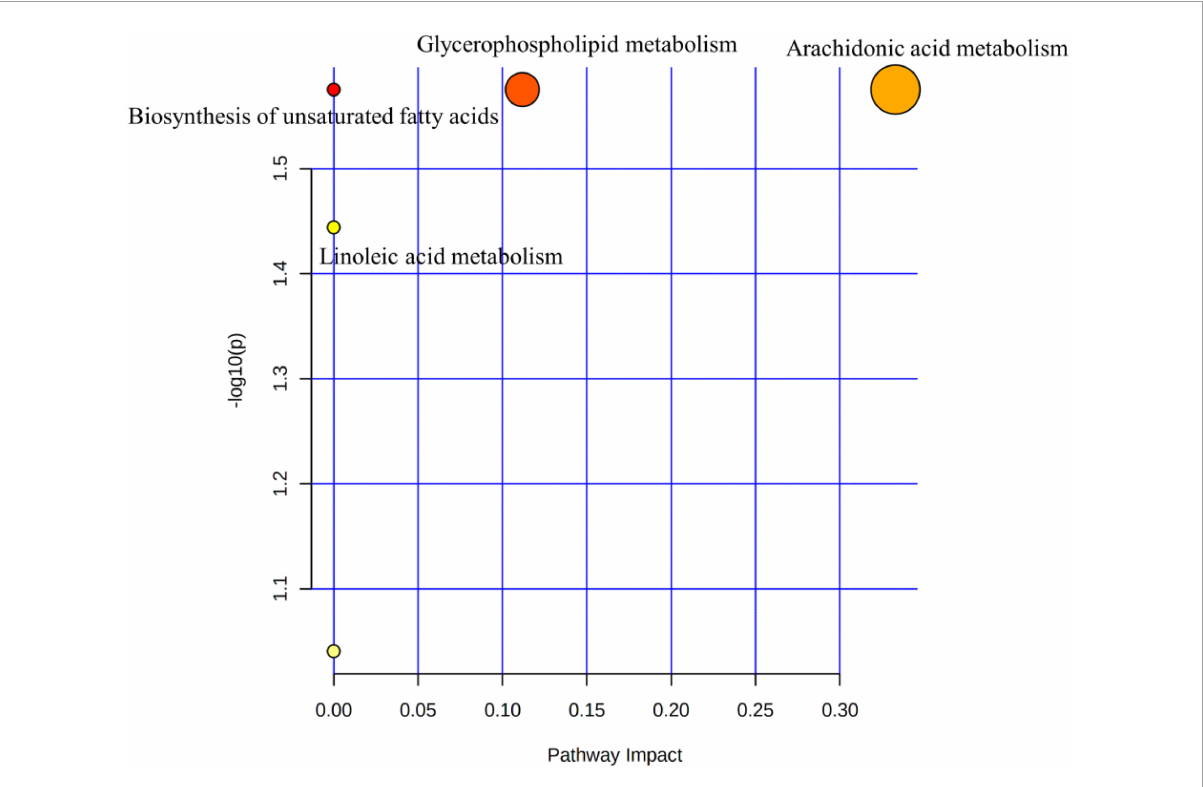
FIGURE5 Metabolic pathway